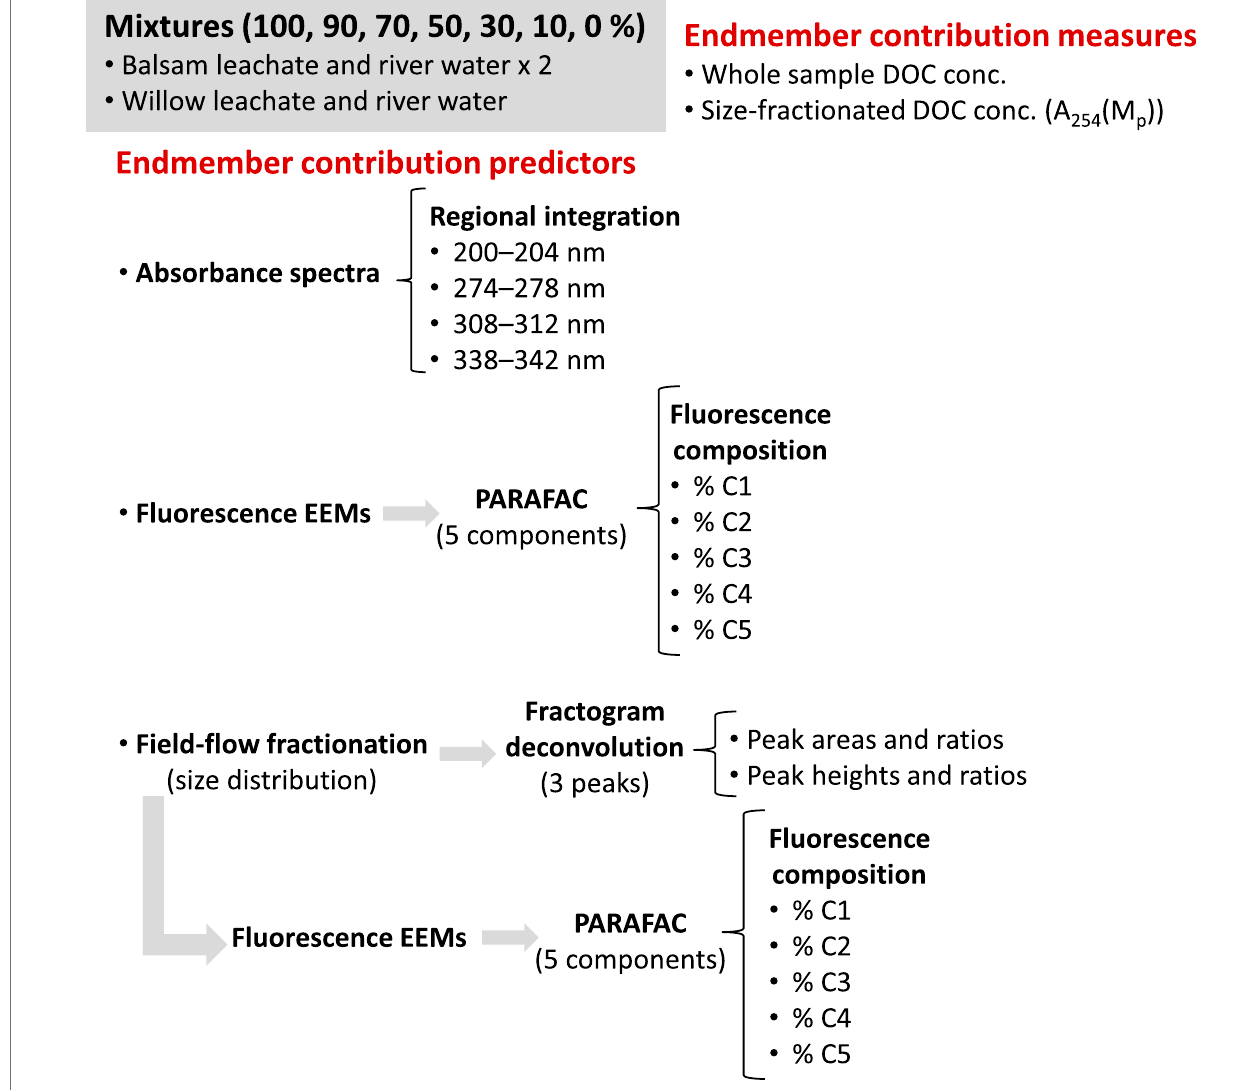
FIGURE 1 | Mixing experiment schematic showing the measurements and associated data analyses that were assessed as potential predictors for endmember contributions.